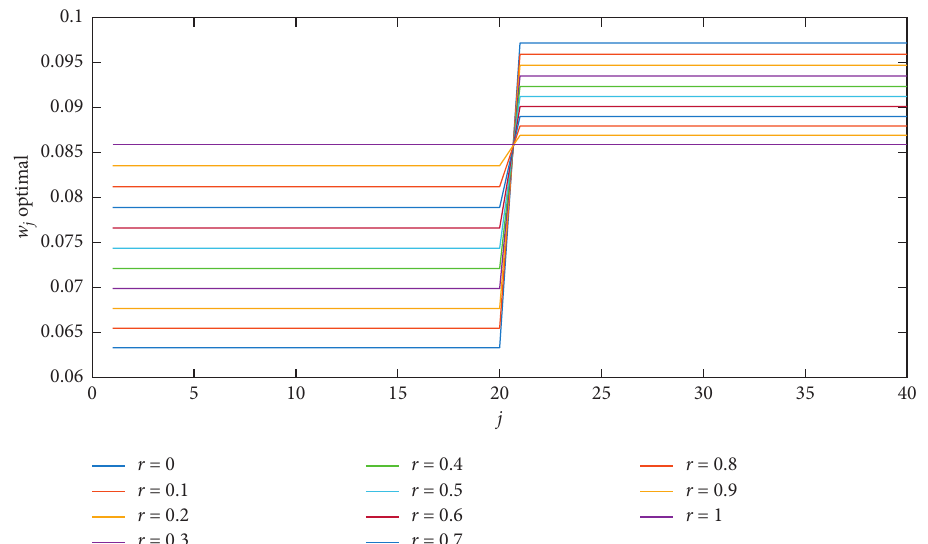
Figure 2: The convergence of the neural network weights for each r -cut.